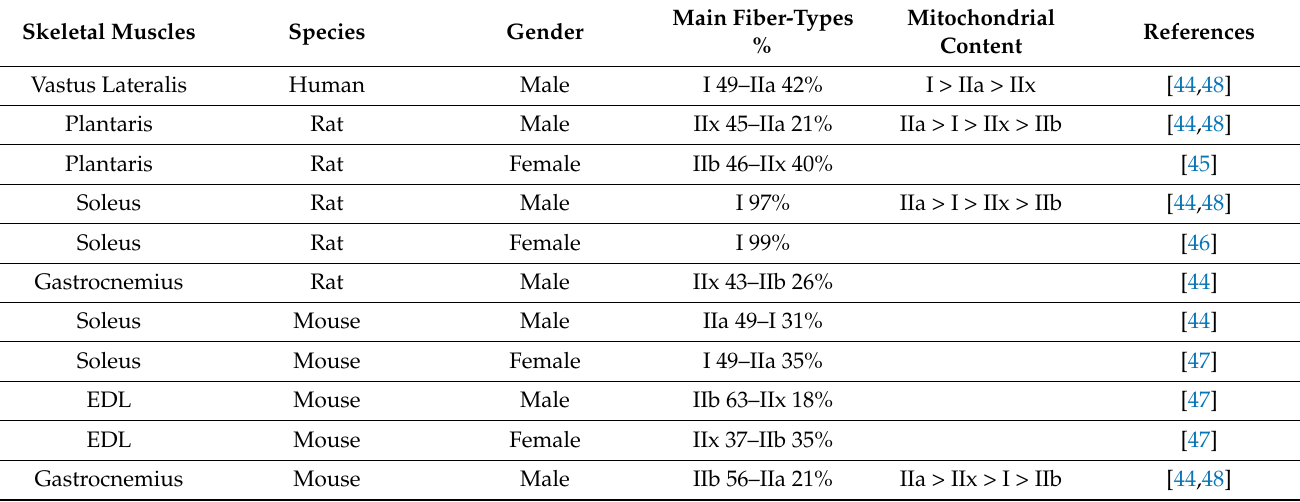
Table 1. Fiber-type distribution and mitochondrial content in different skeletal